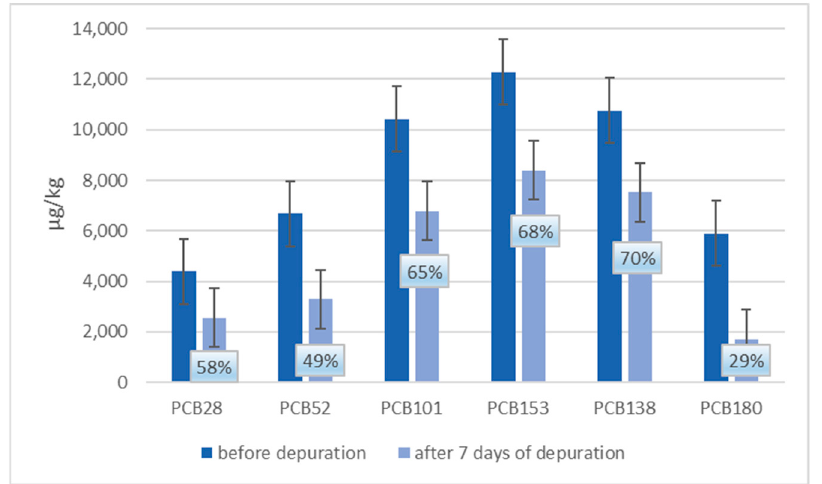
Figure 6. Ndl-PCBs concentration in mussels of merged group 5–6 (TiO 2 NPs and ndl-PCBs treatment) before and after seven days of depuration process. The percentage of ndl-PCBs detected after the depuration process is also reported.